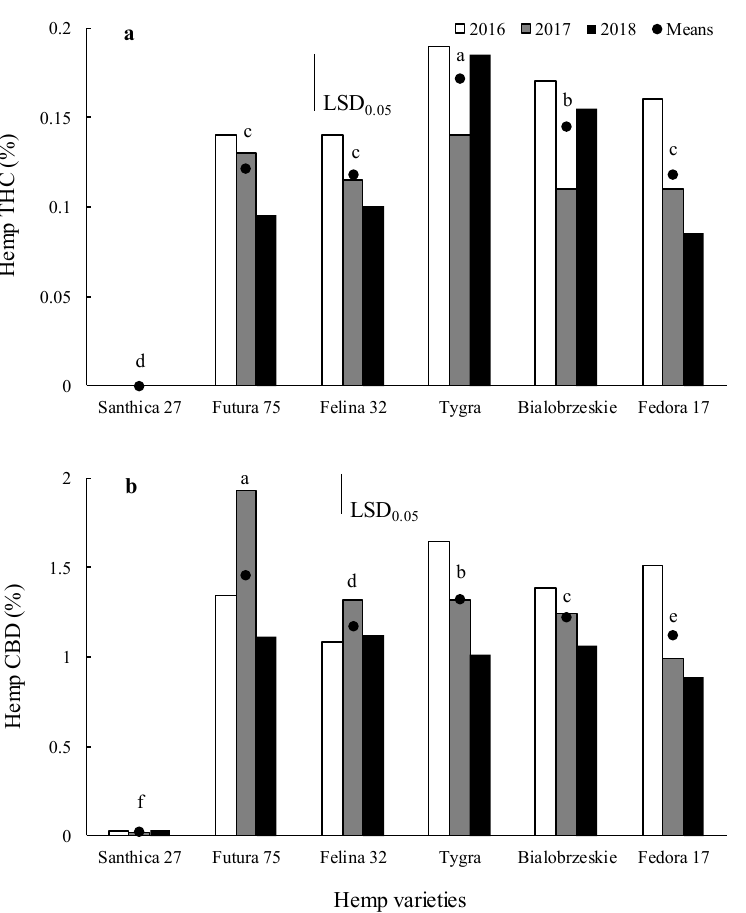
Figure 9. Tetrahydrocannabinol (THC) ( a ) and cannabidiol (CBD) ( b ) content of six industrial hemp varieties. For the year × variety interaction, columns with height differences lower than the LSD height did not significantly differ according to the Fisher’s Protected Least Significant Difference (LSD) test at p = 0.05. For the variety effect, points with the same letter did not significantly differ according to the Fisher’s Protected Least Significant Difference test at p = 0.05.